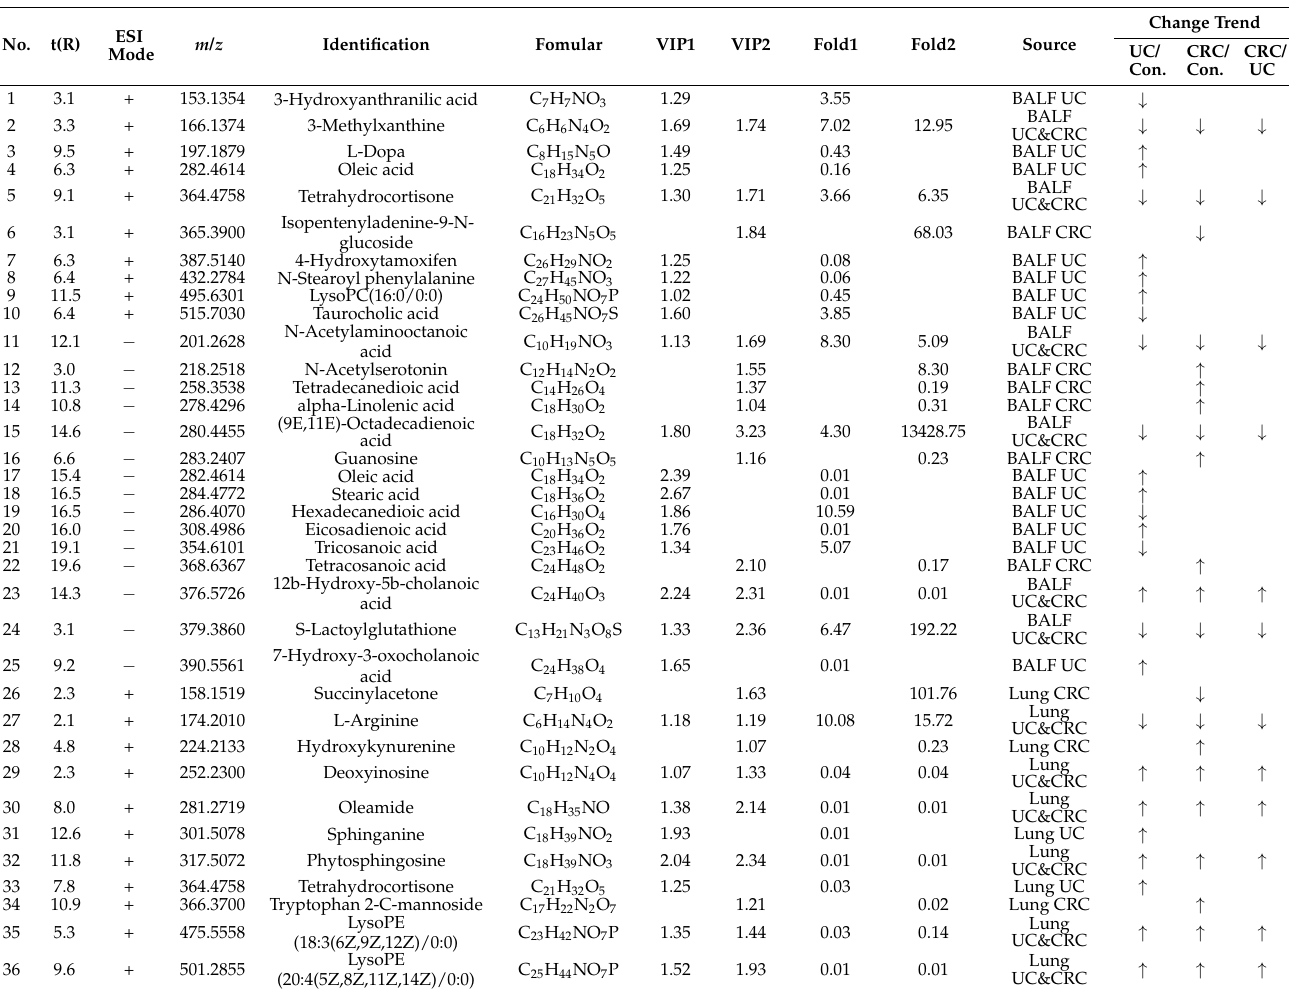
Table 1. The detailed information about the potential biomarkers detected in the ulcerative colitis (UC) group and colorectal cancer (CRC)